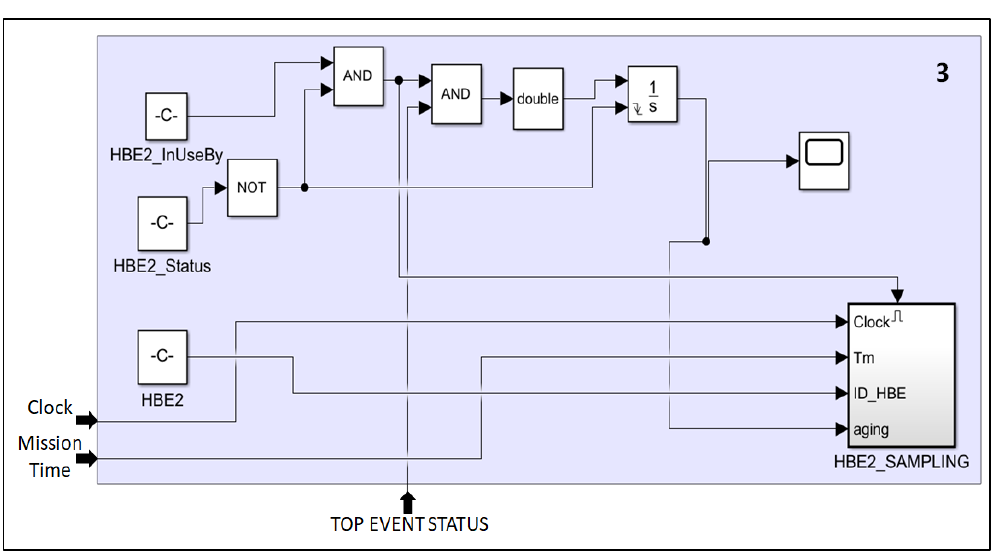
Figure 5. Simulink model of the HBE2 of the case study.